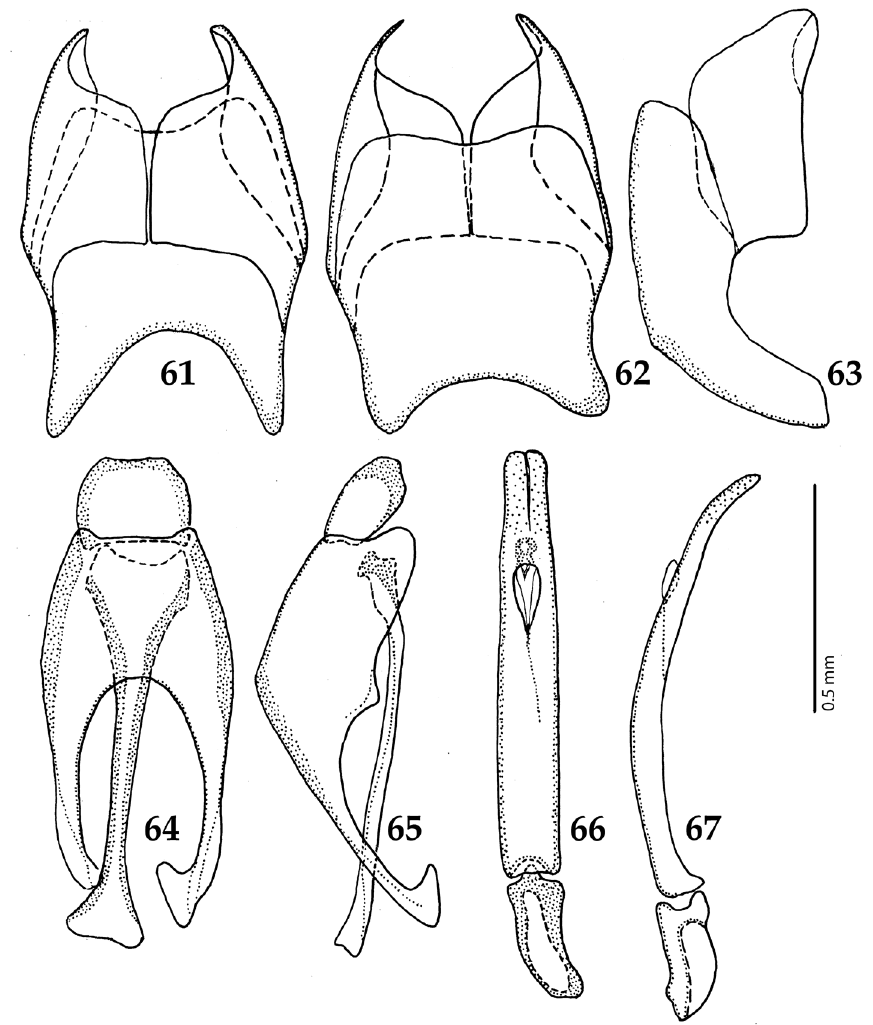
Figures 61–67. 61 Euspilotus ( Neosaprinus ) rubriculus (Marseul, 1855) male terminalia: 8 th sternite + 8 th tergite, ventral view 62 ditto, dorsal view 63 ditto, lateral view 64 9 th + 10 th tergites, dorsal view; spiculum gastrale, ventral view 65 9 th + 10 th tergites + spiculum gastrale, lateral view 66 aedegus, dorsal view 67 ditto, lateral